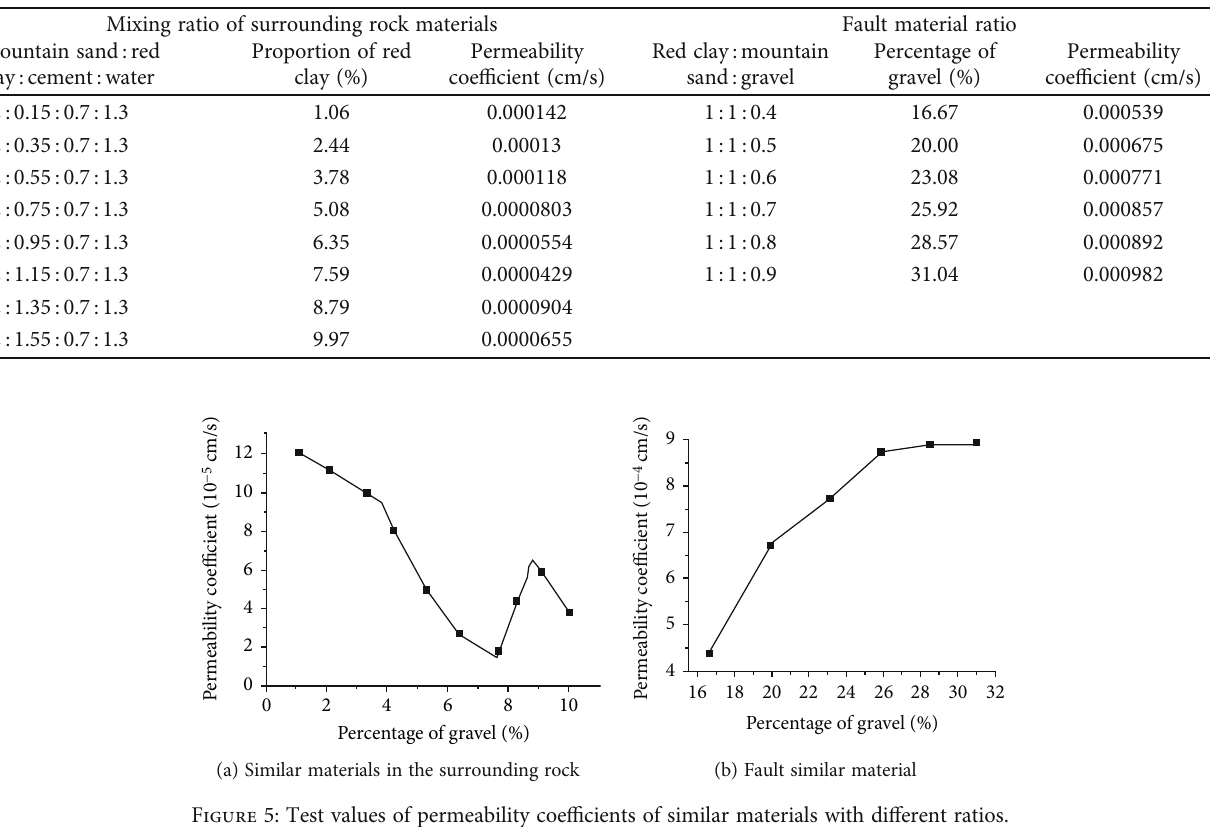
Figure 4: Permeation test operation procedure. Table 4: Permeability coe ffi cient of surrounding rock and fault similar materials.